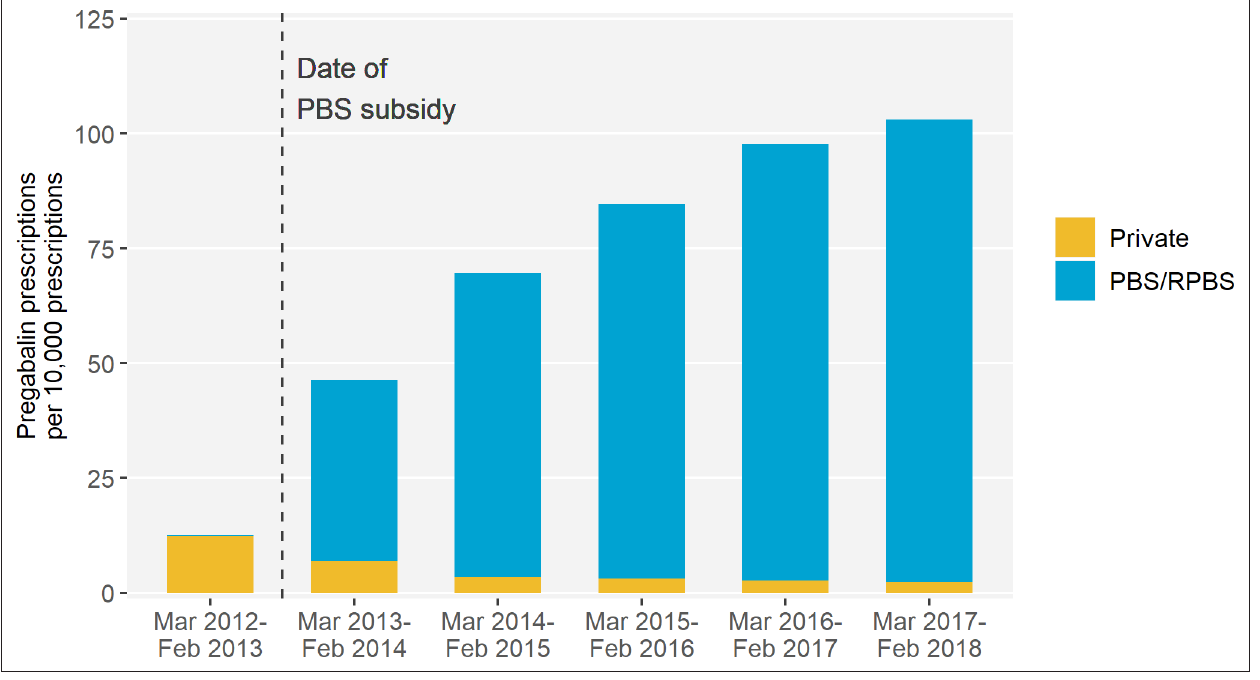
Figure 1 Pregabalin prescriptions as a proportion of all prescriptions by subsidy status. Legend: Excludes 6411 (1.6%) pregabalin prescriptions with missing prescription subsidy status. Prior to March 2013, pregabalin was only subsidised